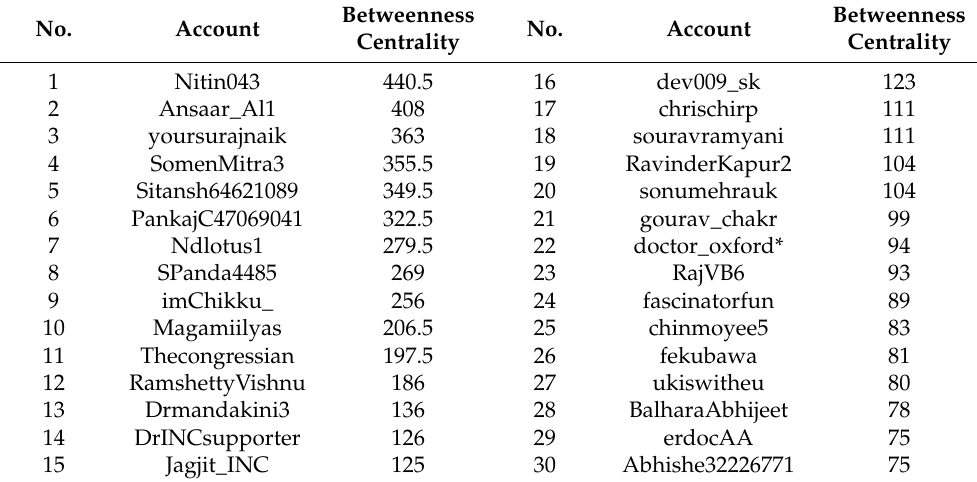
Table 6. Top 30 Twitter accounts by betweenness